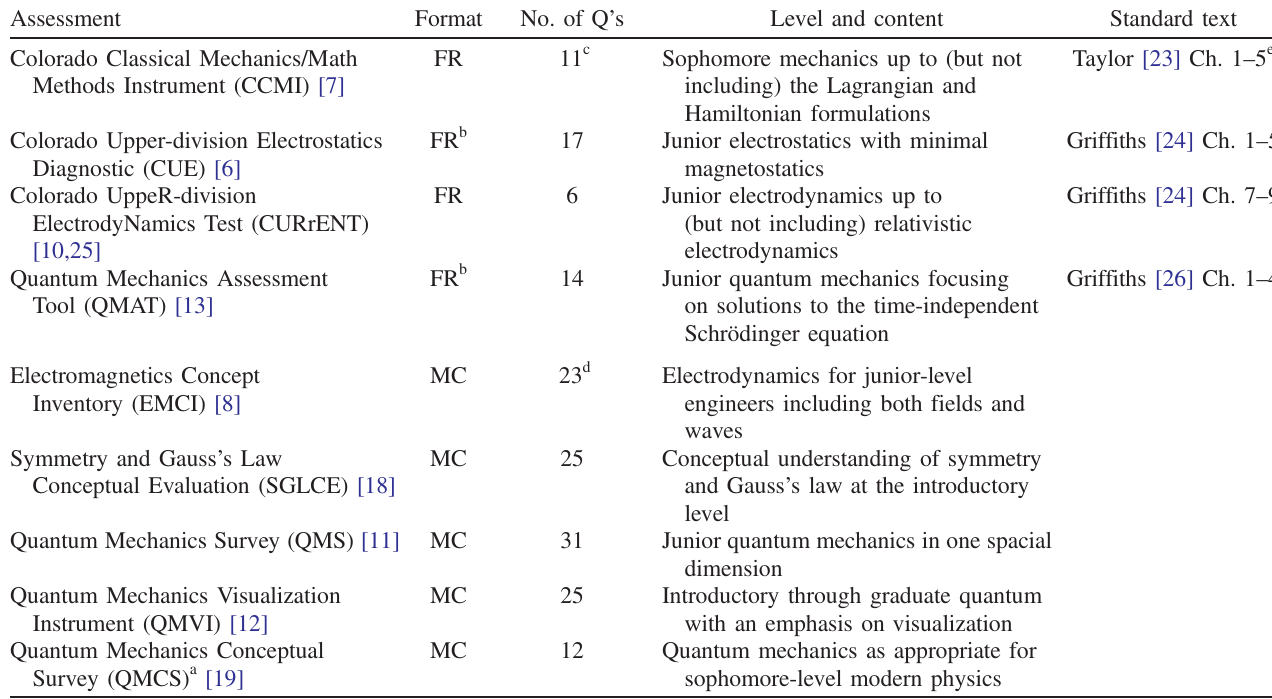
TABLE I. Brief overview of specific upper-division conceptual assessments. The top section includes CU ’ s four named upper-division assessments, and the bottom section includes similar information for several of the major alternative instruments that have been developed for or used at the upper division level. Each assessment is classified as either multiple-choice (MC) if the final numerical score comes from only multiple-choice or multiple-response questions, or free-response (FR)